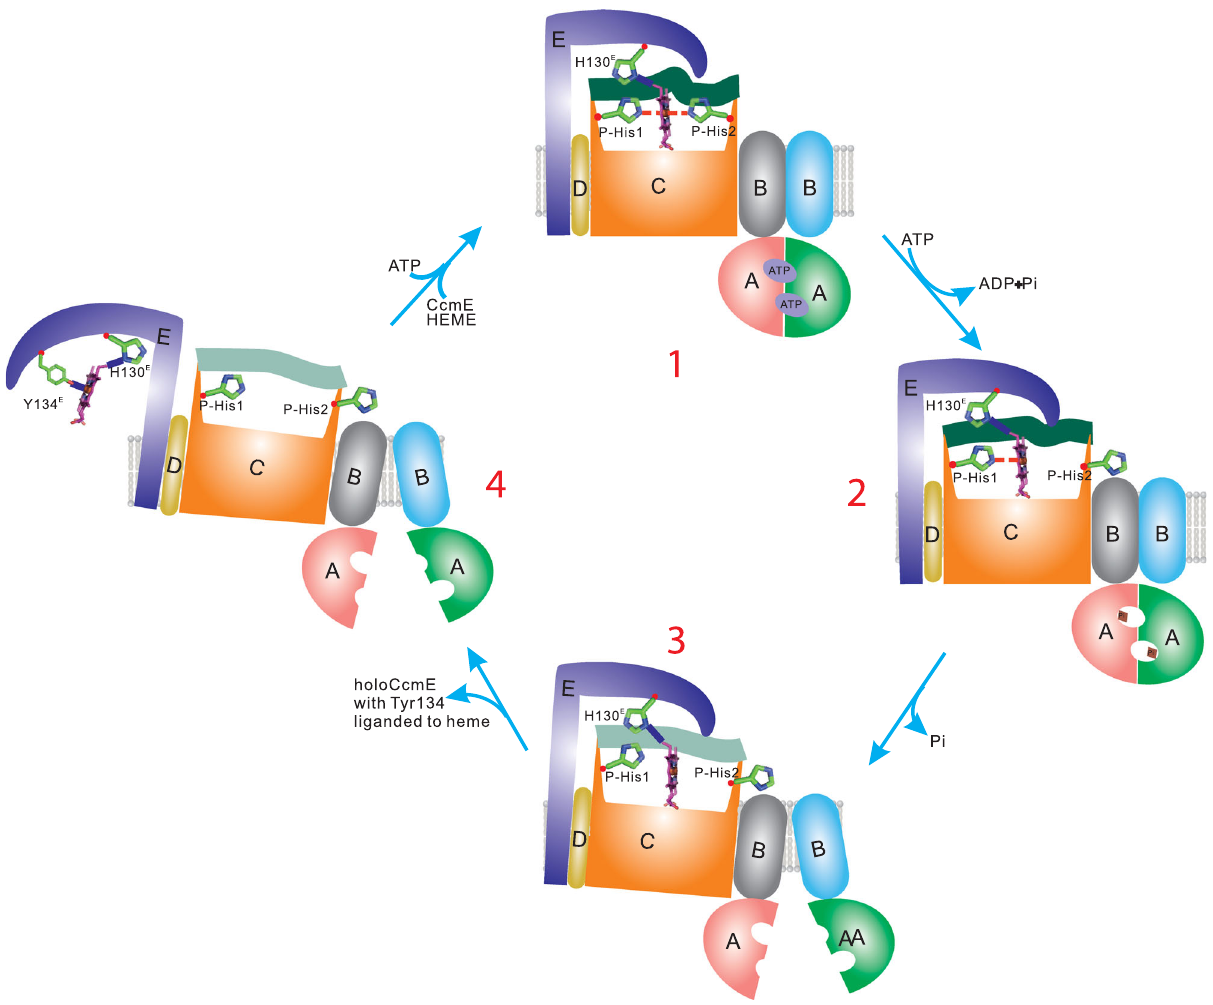
Fig. 6 | Cycle of CcmABCD structures and functions. The general function of CcmABCD is to attach heme to the periplasmic heme chaperone, CcmE, in the System I cyt c maturation pathway. Structures presented here provide the mole- cular basis for this function. The hypothetical cycle begins (#1) with CcmABCD containing all substrates: heme liganded by CcmC P-His1 and P-His2, the His130 E adduct to vinyl 2 of heme, and two ATP molecules bound by a CcmA dimer in the closed NBD state. The structures represented by #1to #4are discussed inthe text,